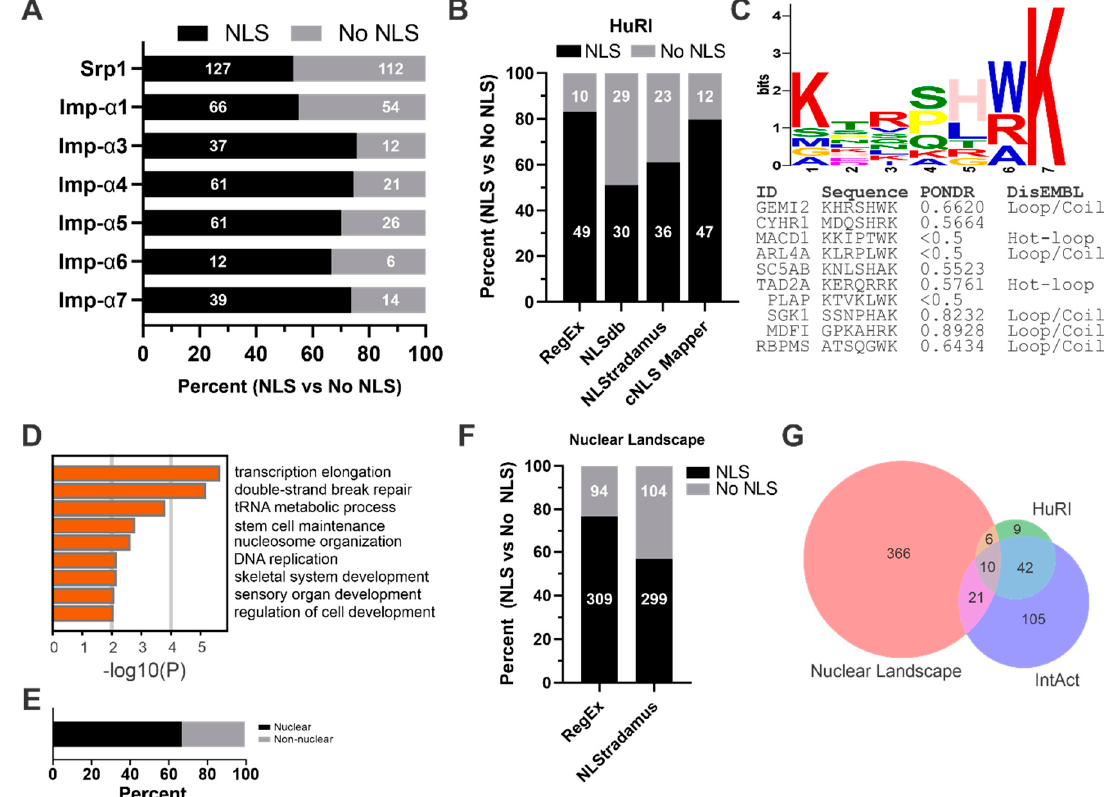
Figure 2. Many Imp- α cargo do not have a predictable cNLS. ( A ) Physical protein interactions, either direct or indirect, for yeast Srp1 and the indicated human Imp- α isoforms were retrieved from BioGrid and IntAct, and analyzed for cNLSs using RegEx matching. Prediction shows between 50% and 80% do not have a predictable cNLS. ( B ) Direct protein interactions for all Imp- α isoforms except Imp- α 8 were retrieved from the Human Reference Interactome (HuRI). Interactors were pooled to remove redundant proteins, and checked against the HPA for evidence of nuclear localization before cNLS prediction. Several prediction programs were used to determine a range of predicted cNLSs, which demonstrated between 50% and 80% do not have a cNLS. ( C ) Proteins without a predicted cNLS from any of the prediction programs were processed with MEME to identify novel motifs common amongst each protein that might interact with Imp- α . Several of the motifs identified were rich in basic amino acids, but did not resemble a cNLS. Disorder prediction using PONDR (VSL2) and DisEMBL shows that these motifs are also found within disordered protein regions. ( D ) The motif KxRxHxK was